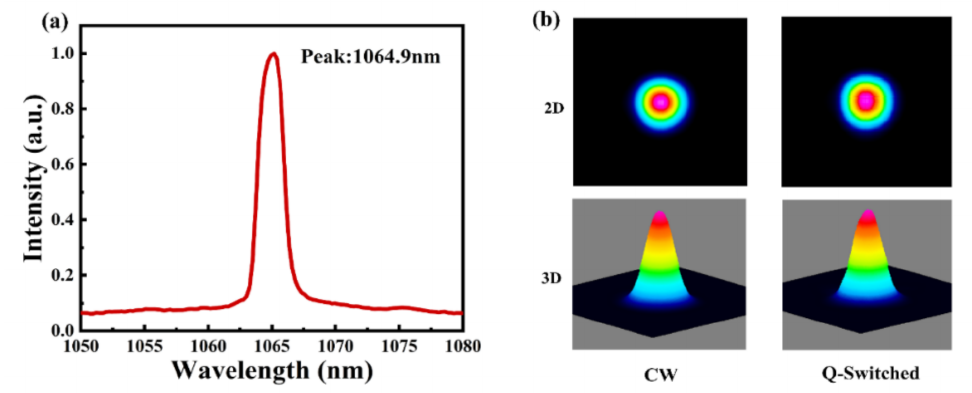
Figure 10. ( a ) Emission spectrum of the Q-switched laser; ( b ) beam profile of the laser in CW and Q-switched